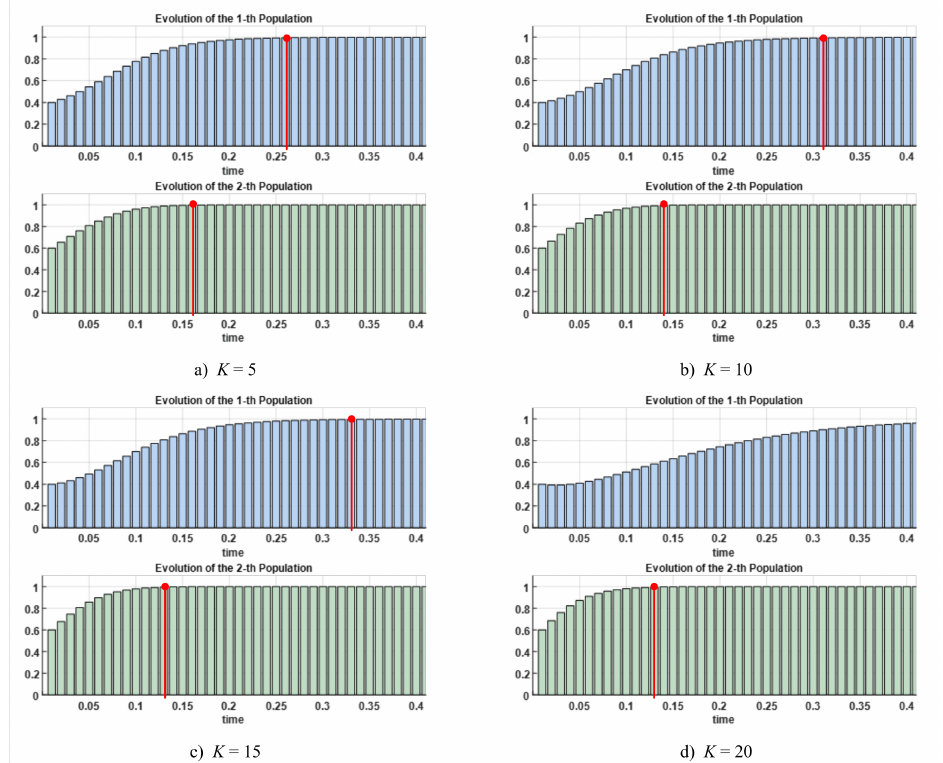
Figure 8. Influence of K change on system evolution (under government supervision).